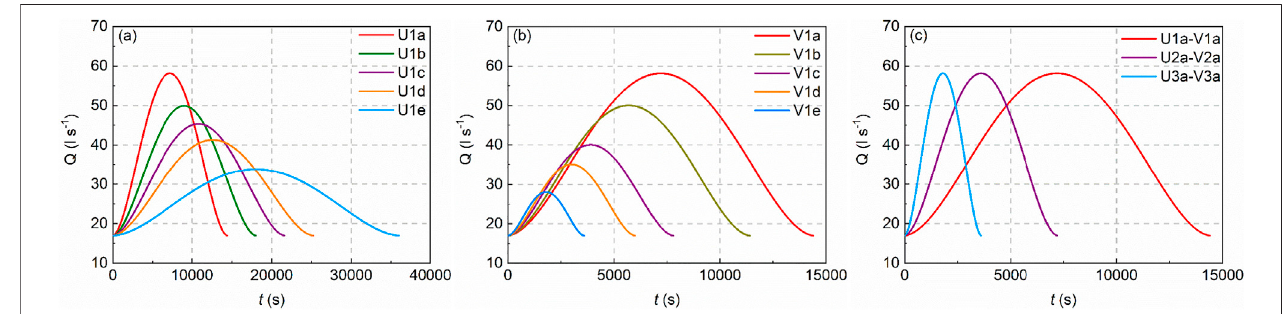
FIGURE 2 | Design fl ow hydrographs with varying (A) unsteadiness Γ HG (group U1), (B) total water work W k (group V1), and (C ) unsteadiness Γ HG and total water work W k (group UV).